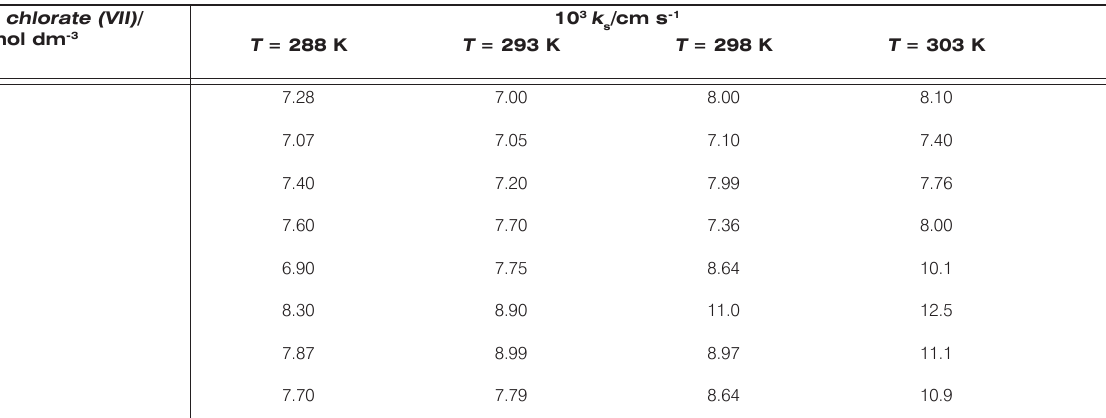
Table 2. The values of standard rate constants k s of 1×10 -3 mol dm -3 Bi(III) ion electroreduction in 1–8 mol dm -3 chlorates(VII) in the presence of 1×10 -2 mol dm -3 cystine vs .